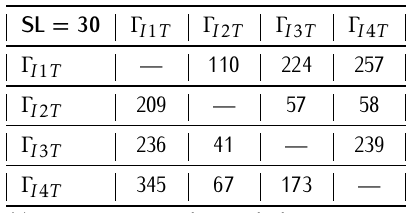
oara to Deva with SL=30 ,